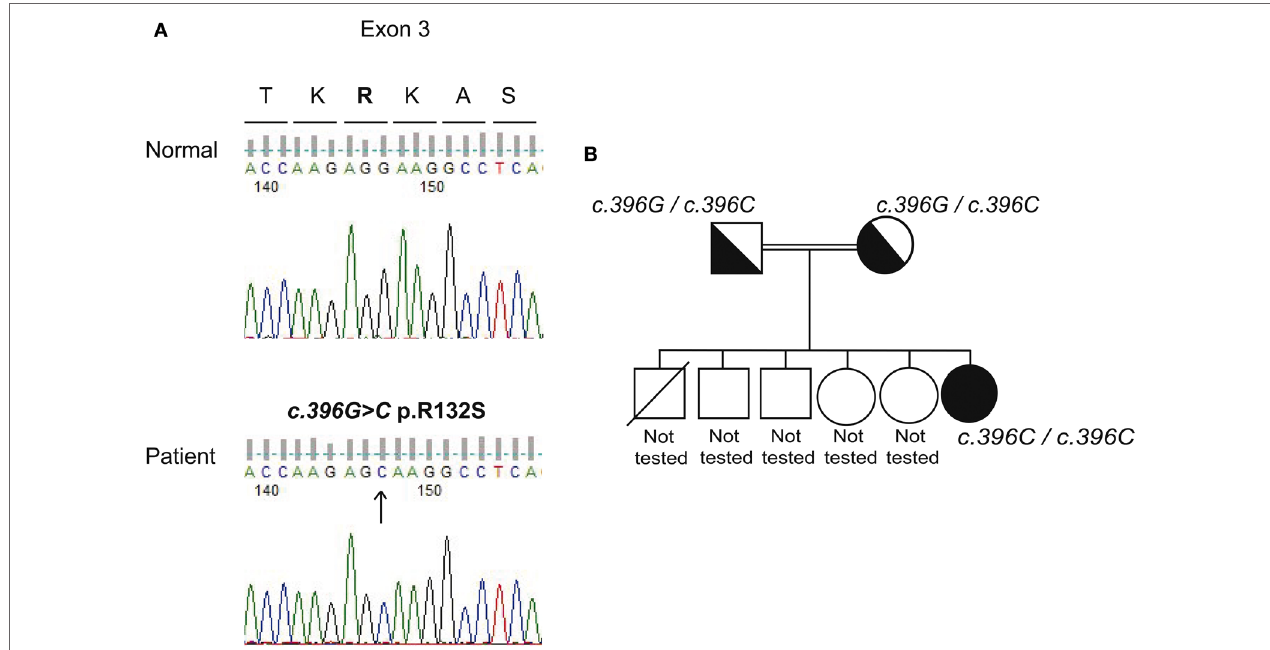
FIGURe 1 | Genetic analysis of the AIRE gene. (a) Electropherograms of representative fragments of exon 3 of the AIRE gene relative to a normal control and the patient. The analysis was performed after informed consent. The wild-type allele for exon 3 is shown for the control (upper panel). The patient (bottom panel) is homozygous revealing two copies of the mutated c.396G > C allele (exon 3). Fifty normal controls tested negative for the novel mutation. (B) The phylogenetic tree relative to the family studies showing the heterozygous state for the novel c.396G > C mutation in both parents and the homozygosity in the patient’s